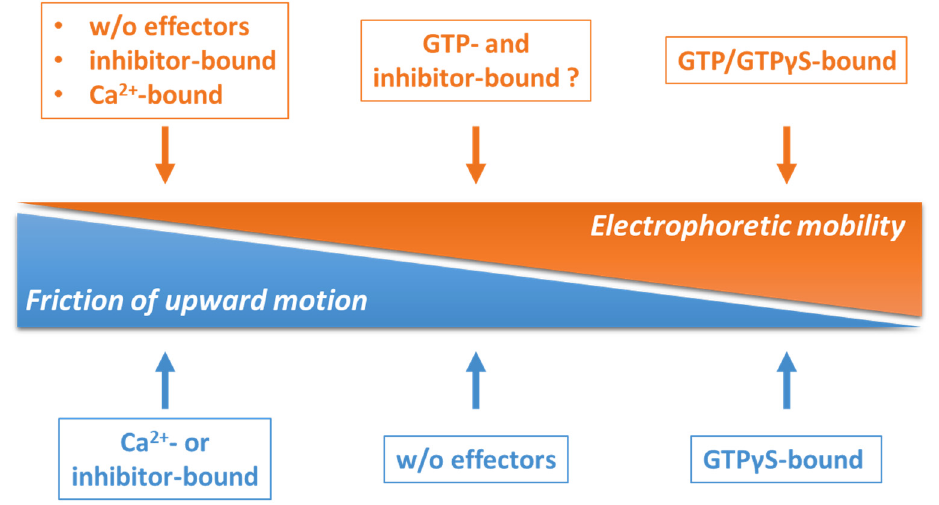
Figure 9. Qualitative comparison of the results on the conformational dynamics of hTGase 2 obtained by switchSENSE ® and native (GTP-)PAGE . For switchSENSE ® , the friction of the upward motion was measured (blue, decreases from left to right). In contrast, for native (GTP-)PAGE , the electrophoretic mobility (orange, increases from left to the right) was assessed.